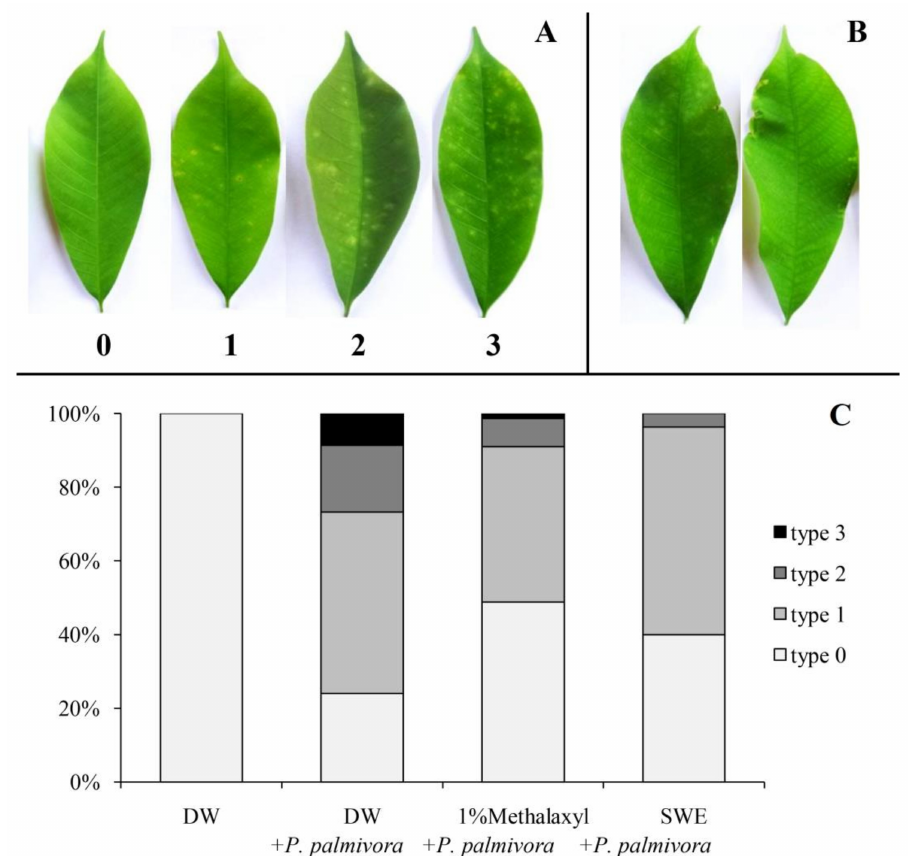
Figure 3. Disease development in the leaves at day 5 after inoculation could be divided into four types; 0 = no infection, 1 = light infection, 2 = moderate infection and 3 = severe infection ( A ); some damage leaves caused by 1% metalaxyl ( B ), and percentage of each type of leaves in each treatment (n = 120) ( C